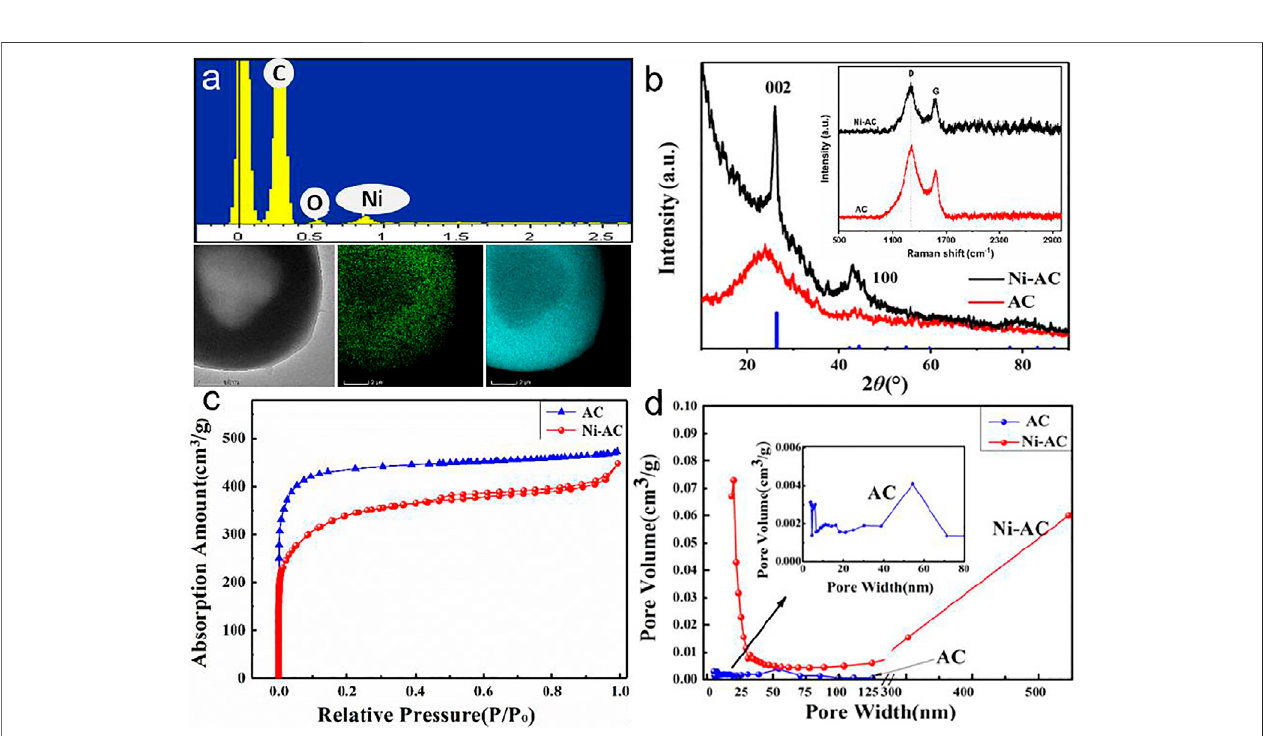
FIGURE2| EDSspectrumandmappingofthecarbonizedprecursorwithNi(CH 3 COO) 2 (A) ,XRDpatternsandRamanspectra (B) ,nitrogenadsorption/desorption isotherms (C) , and pore size distribution curves (D) of the Ni-AC and AC.